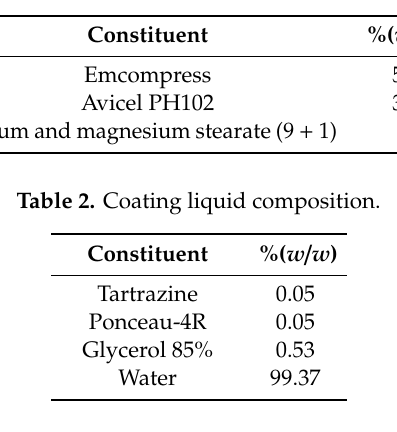
Table 1. Tablet composition.